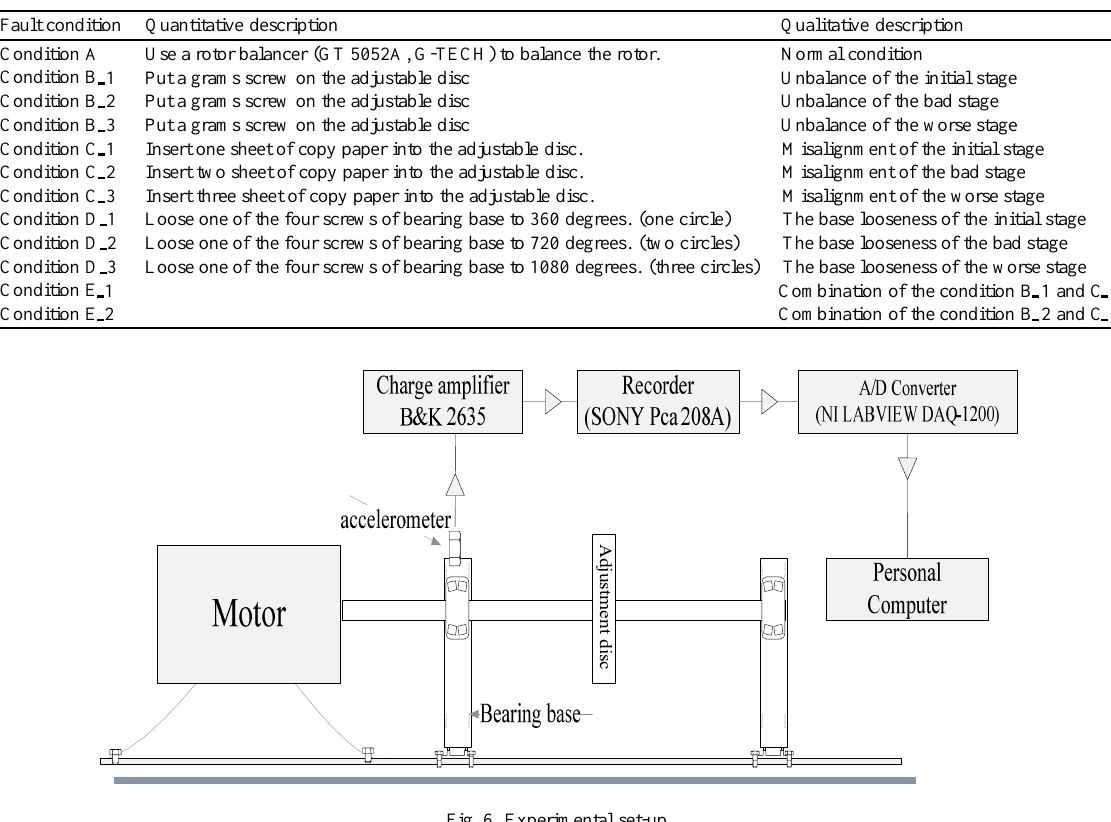
Fig. 6. Experimental